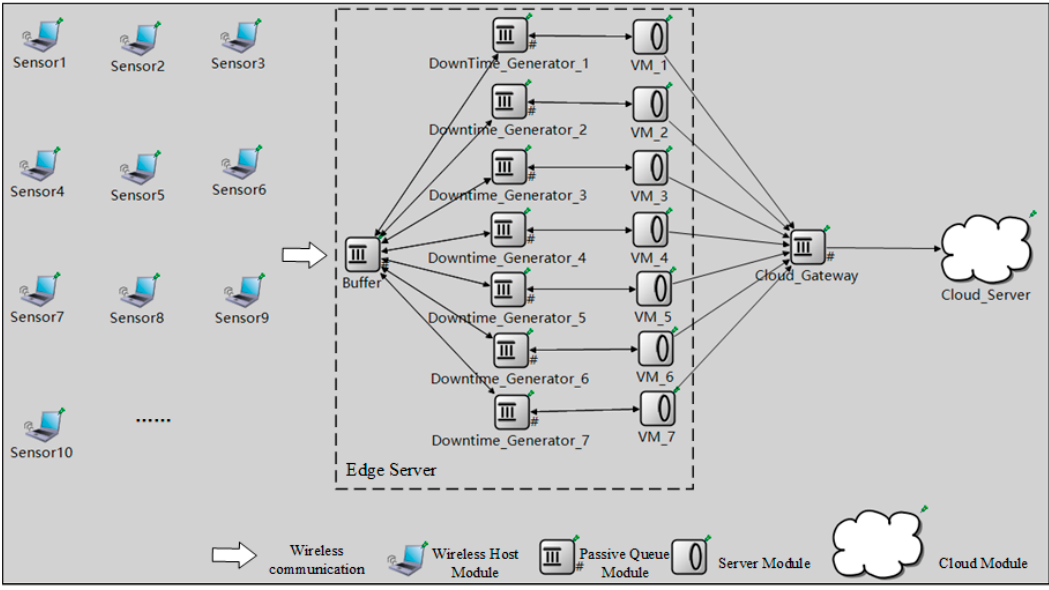
Figure 8. Simulation model in OMNeT++.